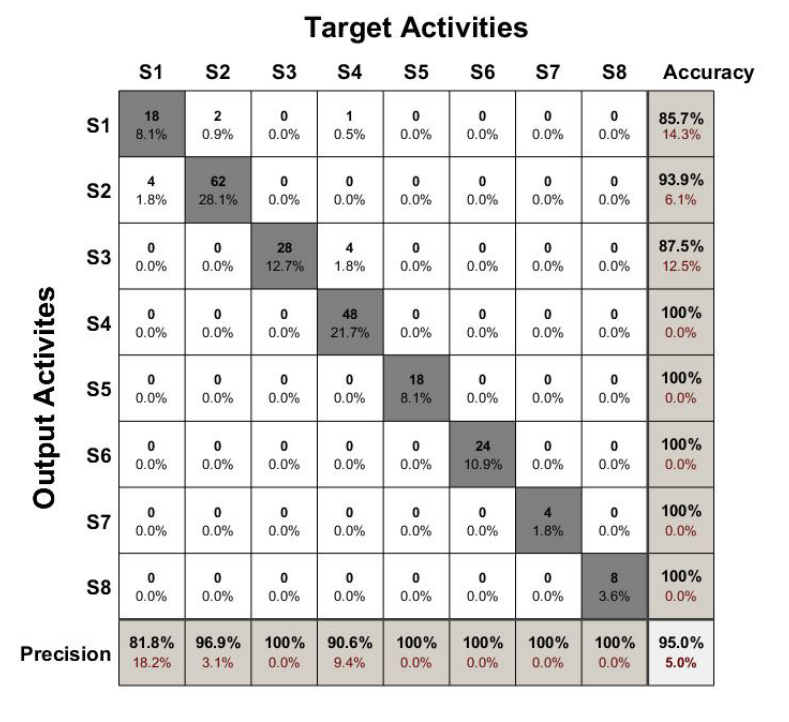
Figure 7. Data collected from a real environment over five days: ( a ) multilevel activity graph; and ( b ) scattered data based on start times and activity duration.